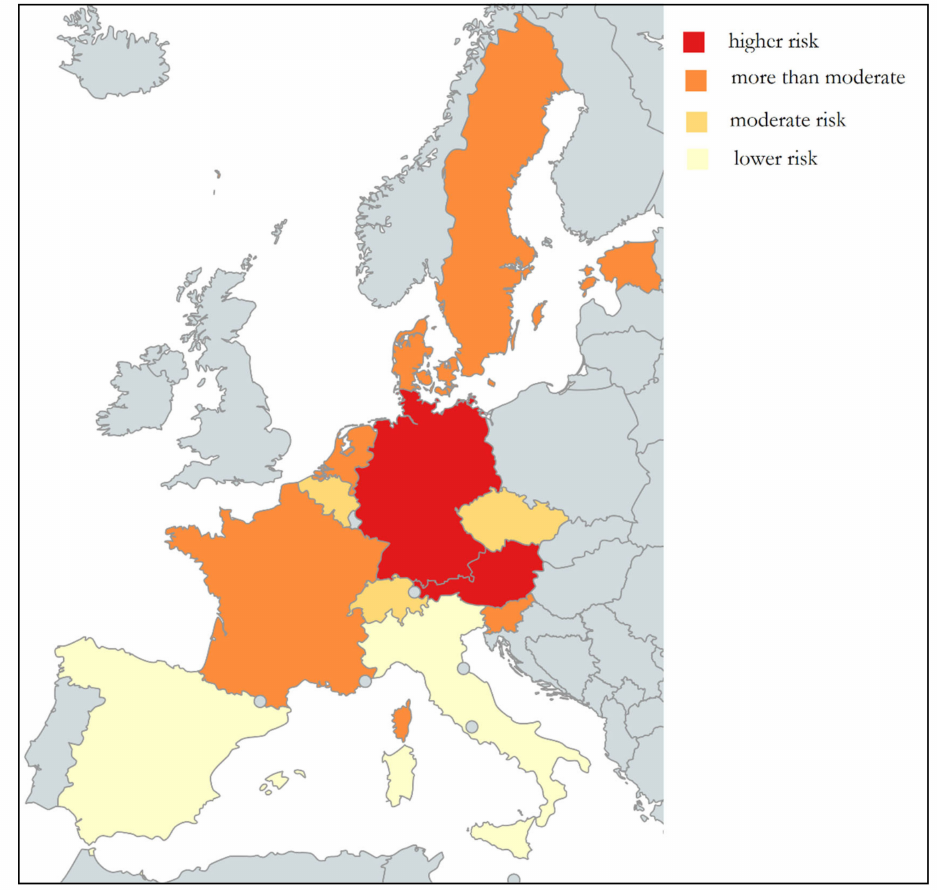
Figure 1. Adjusted risk of hospitalization in analyses countries. Gray color indicated no country analyzed. Darker colors indicate higher